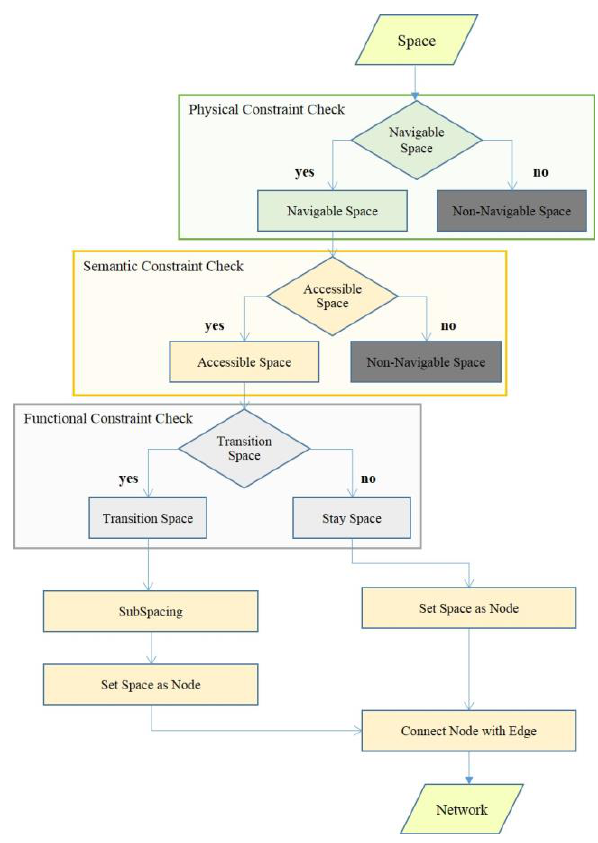
Figure 3. Flowchart for Constructing Indoor Network